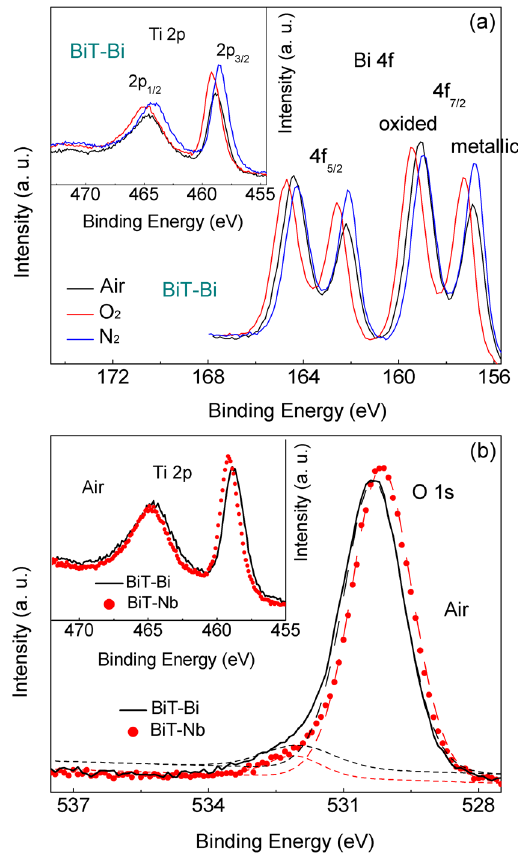
Figure 12. ( a ) Bi 4f and Ti 2 p (inset) XPS spectra of the air, O 2 and N 2 BiT-Bi samples. ( b ) compared O 1 s and Ti 2 p (inset) XPS spectra of the air BiT and BiT-Nb, where the O 1 s spectra were deconvoluted into two natural components by Gauss-Lorentz method (solid lines are experimental data, and dotted lines are fitting